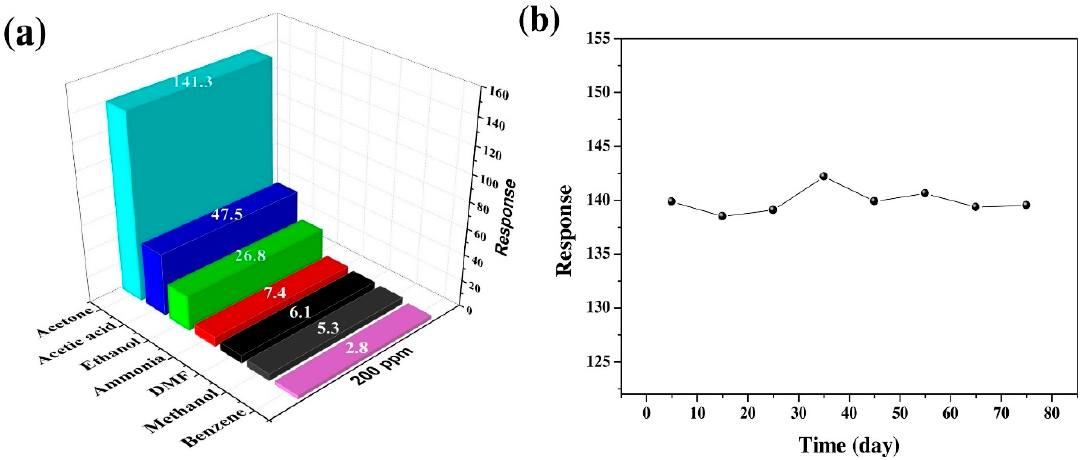
Figure 3. ( a ) The responses to different gases of 200 ppm at 180 °C and ( b ) the long-term stability of all the sensors to 200 ppm acetone at 180 °C (reproduced with the permission from reference [96]).